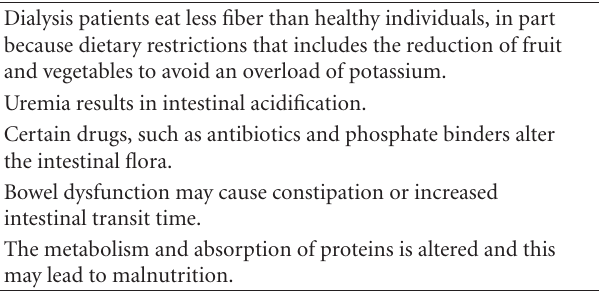
Table 2: Causes of CKD patients intestinal dysbacteriosis. Dialysis patients eat less fiber than healthy individuals, in